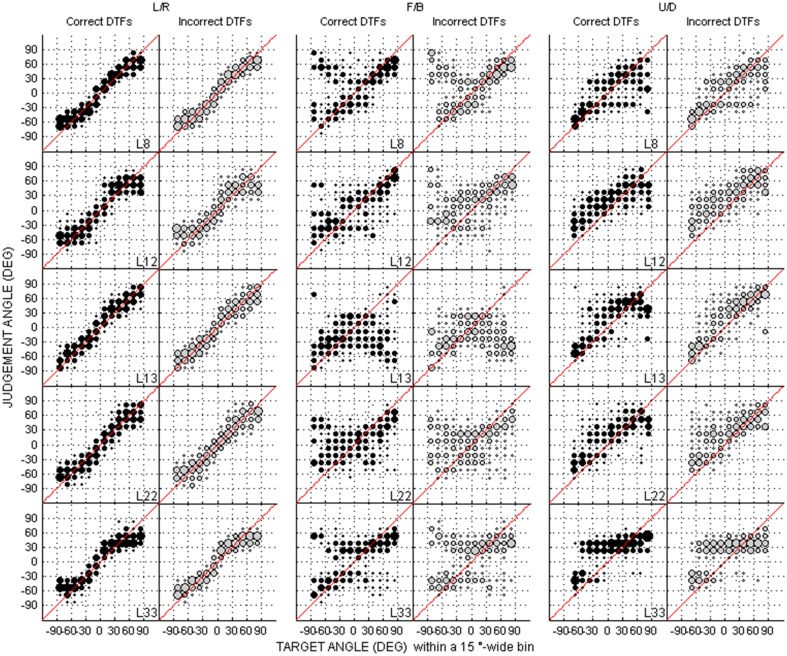
Individual judgment position against target position using correct and incorrect DTFs (black and gray dots, respectively) with individual HRTFs in the left/right, up/down, and front/back dimensions. Each panel couple is for a different listener (N = 5).